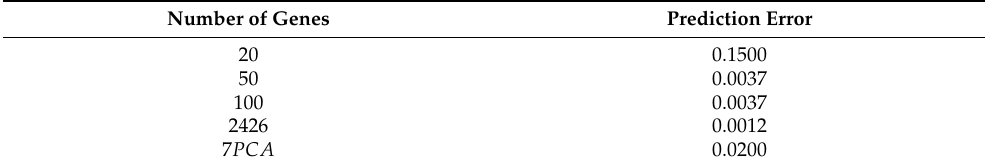
Table 2. Training error rate by 1-nearest neighbor classifier with various number of genes or PCAs.